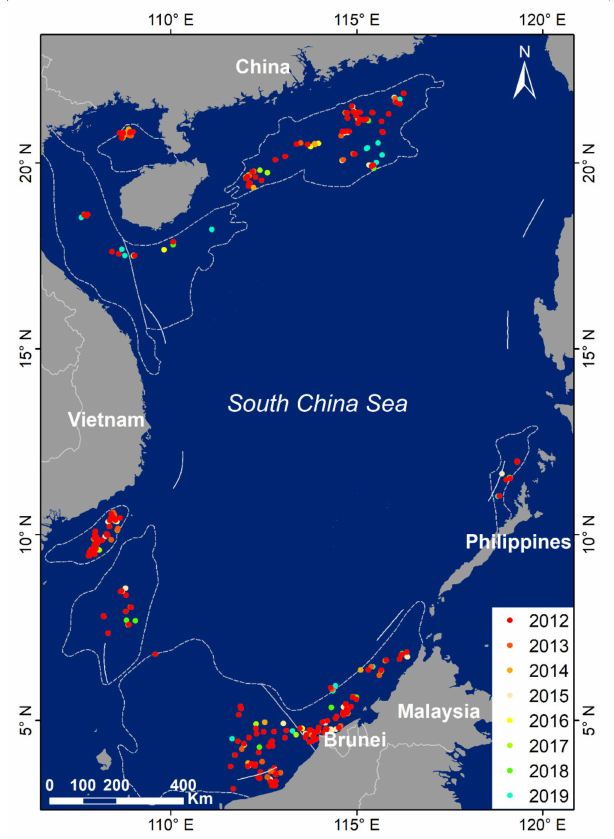
Figure 9. Recognition results of offshore HE targets from 2012 to 2019.